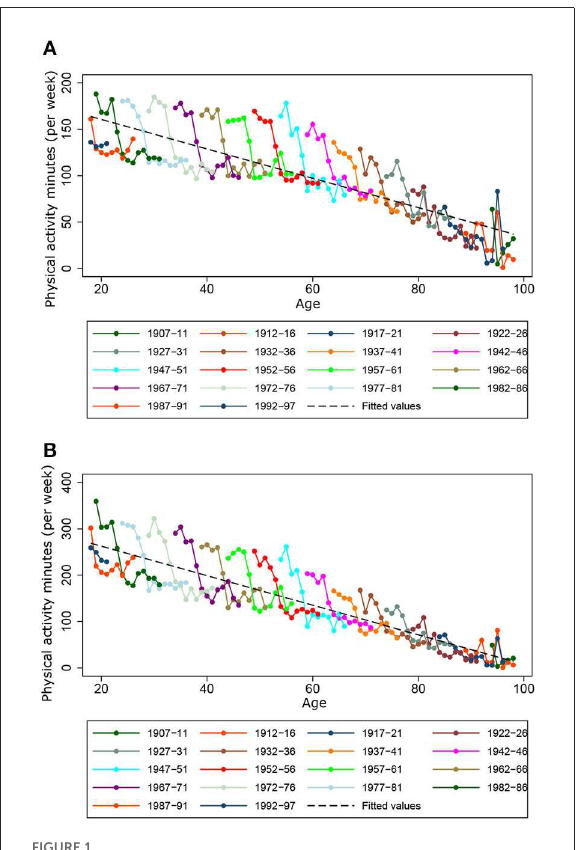
FIGURE1 Average physical activity minutes per week. (A) Simple average. (B) Weighted average.